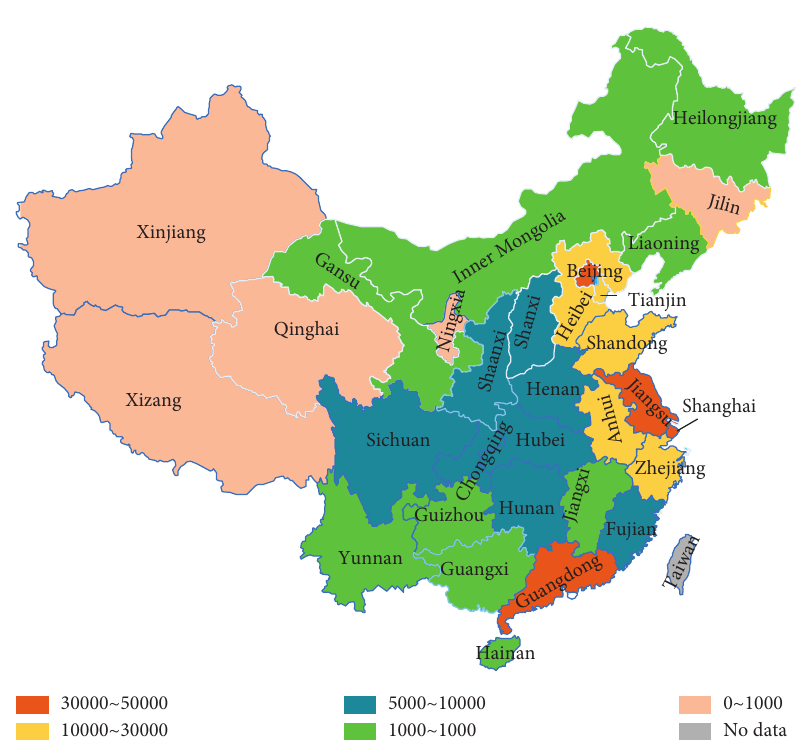
Figure 2: Distribution of electric vehicle charging stations in major provinces and cities in China (excluding Hong Kong, Macao, and